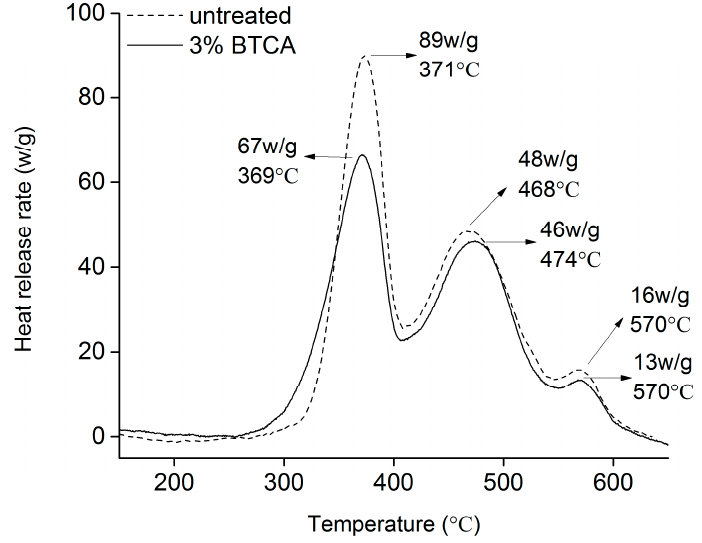
Figure 2. The heat release rate vs. temperature curves of the untreated Nomex ® /cotton fabric and that treated with 3% 1,2,3,4-butanetetracarboxylic acid (BTCA), cured at 170 °C for 3 min and finally subjected to one home laundering cycle.